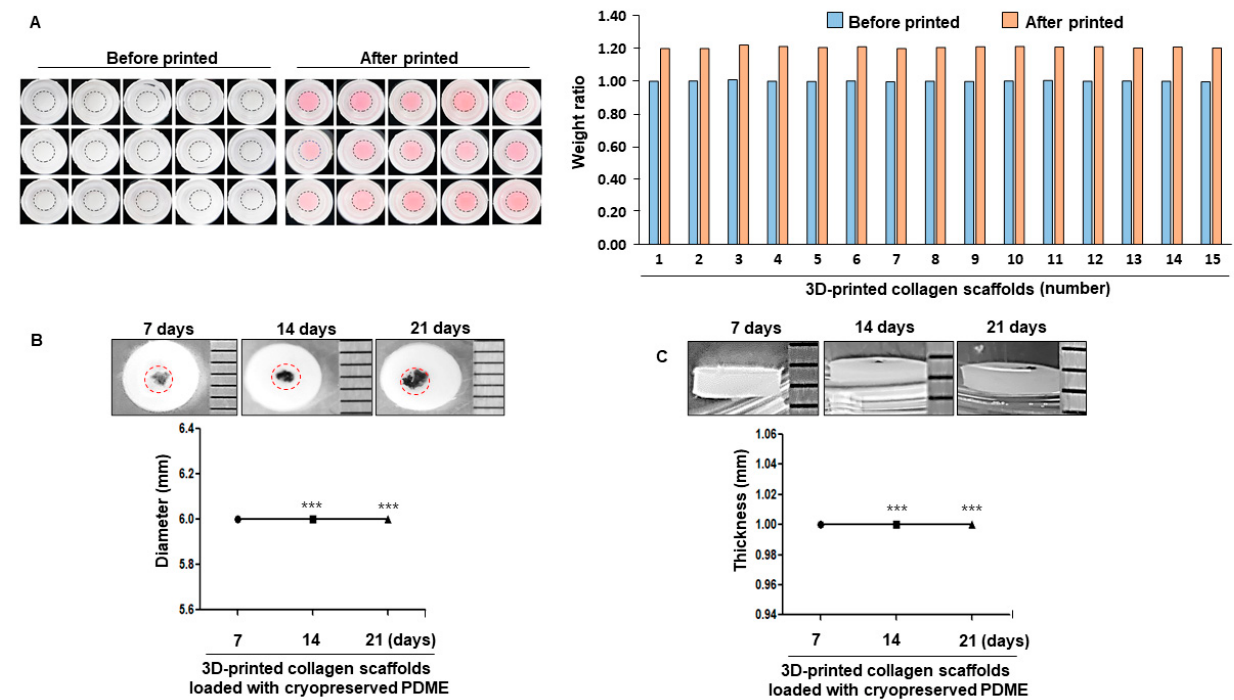
Figure 3. Long-term stability of 3D-printed collagen scaffolds loaded with cryopreserved PDME in a time-dependent manner. ( A ) Representative images showing 3D-printed collagen scaffold-on-frame constructions. The graph indicates the uniform weight of collagen scaffold-on-frame constructions before the 3D-printed group (blue box) and after the 3D-printed group (red box). ( B ) Diameter images of 3D-printed collagen scaffold loaded with cryopreserved PDME at the indicated time points. The graphs indicate the diameters of the respective groups. Red circles show cryopreserved PDME. ( C ) Thickness images of 3D-printed collagen scaffolds loaded with cryopreserved PDME at the indicated time points. The graph depicts thickness measurements. The diameter and thickness were measured with a ruler. Scale bars, 1 mm. All data were obtained from three independent experiments. *** p < 0.001 versus 3D-printed collagen scaffolds-loaded with cryopreserved PDME at 7 days using Student’s t -test